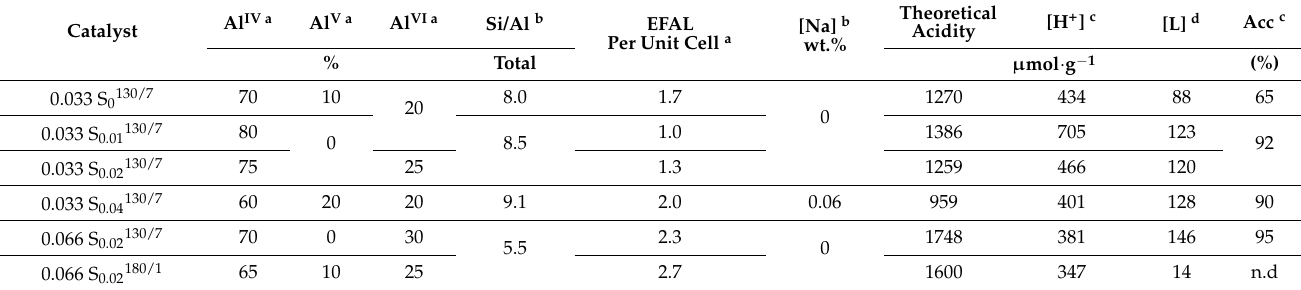
Table 2. Acidic properties of the synthesized MOR-type zeolites obtained in the absence or in the presence of CTAB. Catalyst Al